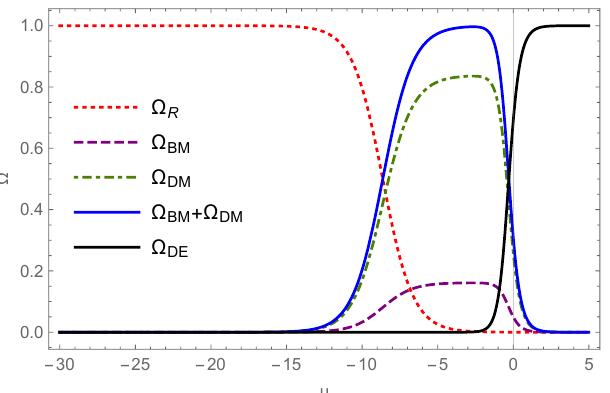
Figure 2. Evolution of the density parameters of radiation, baryonic and dark matter, and dark energy for λ = 2. The transition from a radiation- to a matter-dominated universe occurs well after the primordial nucleosynthesis epoch; the (baryonic and dark) matter-dominated era lasts long enough for structure formation to occur; the transition to a dark-energy-dominated universe takes place in a recent past. At the present time u 0 = 0 the density parameters are Ω DE 0 = 0.69, Ω DM 0 = 0.26, Ω BM 0 = 0.05, and Ω R 0 = 5 × 10 − 5